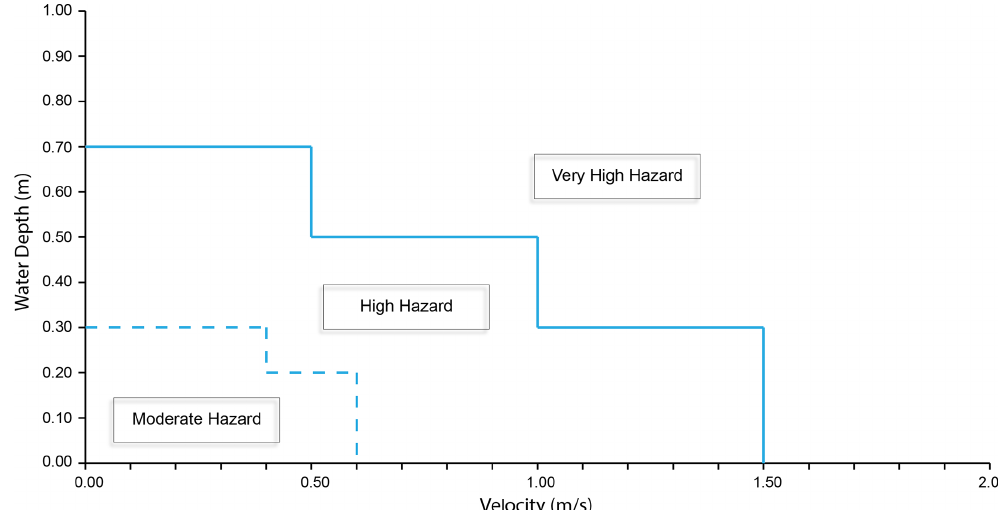
Figure A1. Flood depth and velocity thresholds used as reference values for the flood hazard classification (adapted from Lombardy Region